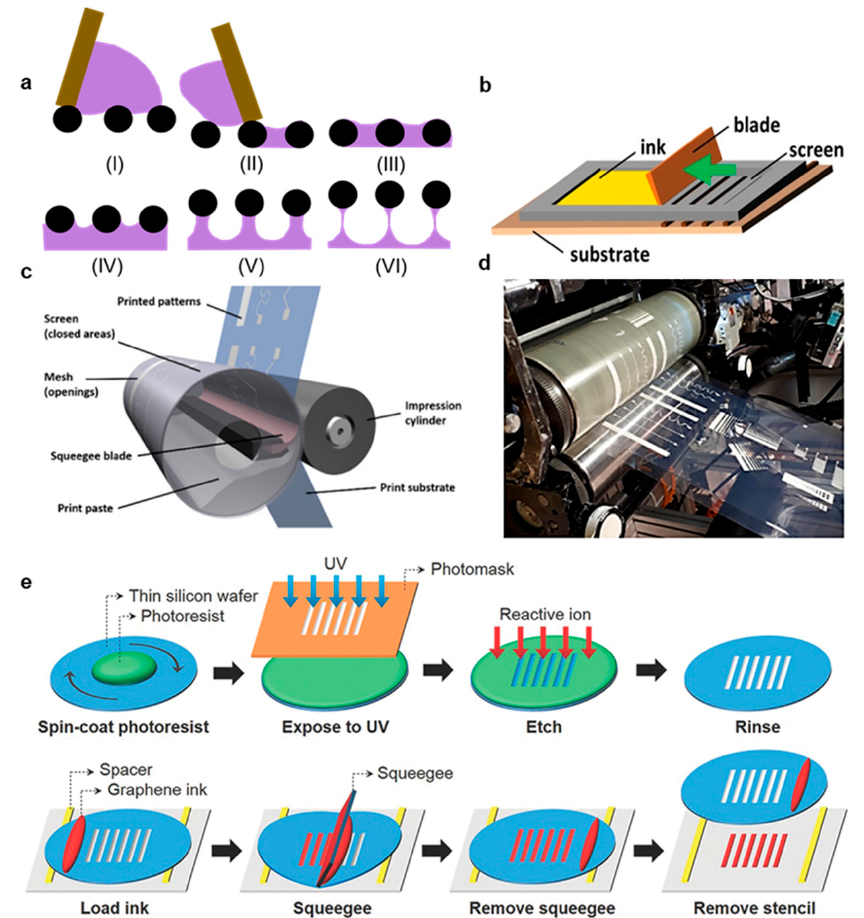
Figure 4. High-throughput screen-printing approaches. ( a ) Illustration of the six stages of screen printing, as proposed by Messer- schmitt et al. and investigated Abbott et al. (i) Ink flooded into the mesh. (ii) Squeegee pressure brings the mesh in contact with the substrate. (iii) Ink adheres to both the substrate and mesh. (iv-vi) As the mesh is raised off the substrate, the ink first (iv) forms a continuous structure, then (v) forms filaments, which then (vi) collapse and level to form a deposition. (reprinted with